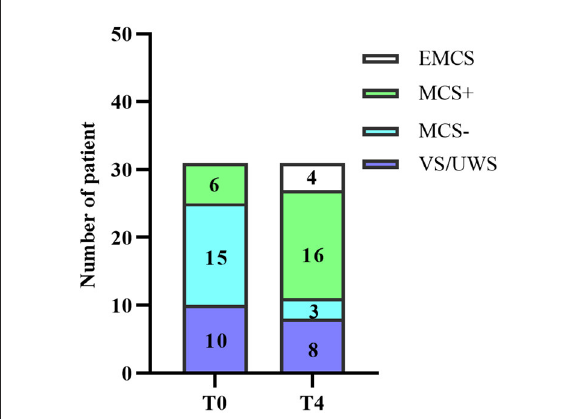
FIGURE6 Changes in clinical diagnosis before and after treatment. T0: before the treatment; T4: 3 months follow-up.